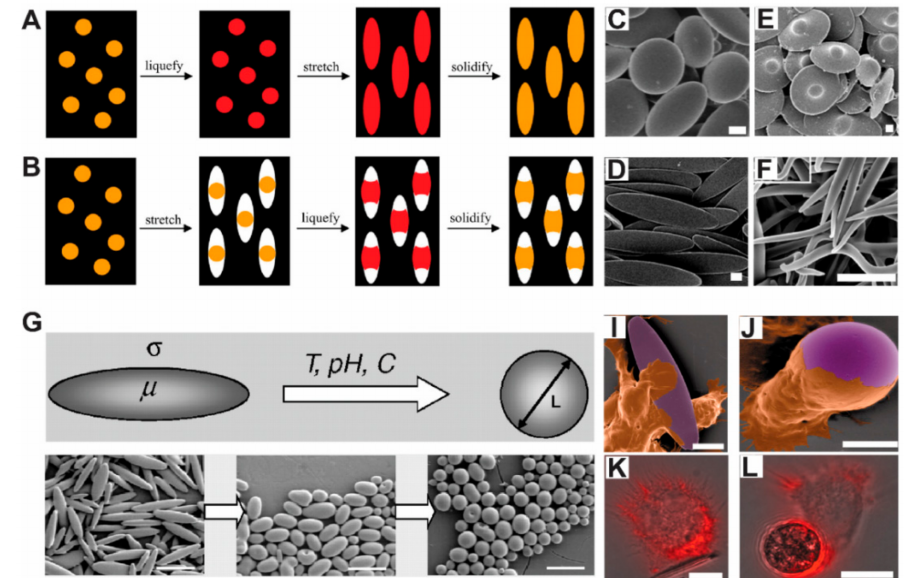
Figure 6. Mechanical stretching techniques were used to produce micro/nanoparticles for delivering therapeutic cargos. This group of techniques can be classified into two methods: ( A ) In the first method, thermoplastic spherical particles (i.e., polystyrene or PLGA) were embedded in a thin film of PVA. The particles were liquefied by heat or organic solvent, followed by stretching the PVA film with mechanical forces to create extra space, where the liquefied materials will fill in the space. Last, a cooling step was used to solidify the particles [83]. Copyright (2007) National Academy of Sciences; ( B ) In the second method, the PVA film embedded with thermoplastic particles was first stretched to generate some extra space for the particles, followed by liquefying the particles with organic solvent or heat to fill into the space. Particles were solidified by evaporating the solvents or lowering temperature [83], with copyright permission from © (2007) National Academy of Sciences. These techniques can generate particles with variable shapes such as ( C ) disk shape; ( D ) disk shape with a dot in the center; ( E ) elliptical shape; and ( F ) needle shape [83]. with copyright permission from © (2007) National Academy of Sciences; ( G ) Researchers studied the major factors that affect particle shapes including heating temperature, pH and particle viscosity and cooling speed [82], with copyright permission from © (2007) National Academy of Sciences. Using these particles, the researchers illustrated the impact of shape on the internalization of particles by macrophages. Artificially color-enhanced mages of macrophages internalizing ( I ) elliptical and ( J ) spherical shape particles. Fluorescence microscope showing the internalization of ( K ) elliptical and ( L ) spherical particles by macrophages [20], with copyright permission from © (2006) National Academy of Sciences. This study illustrated that the contact point between particles and macrophages will affect the internalization speed, where macrophages take up spherical particles more easily than elliptical particles of similar